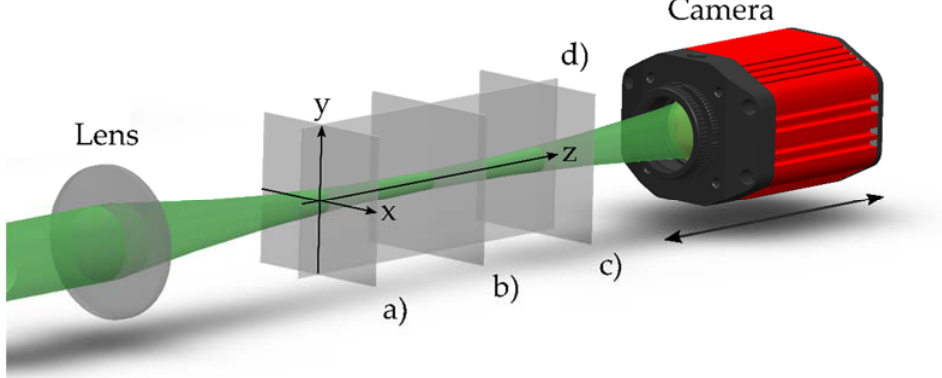
Figure 3. Experimental scheme consisting of a focusing lens and a CMOS-camera. The planes ( a – c ) show the cross-sections of the intensity distributions captured along the propagation axis. The plane ( d ) marks the longitudinal section of the intensity distribution.